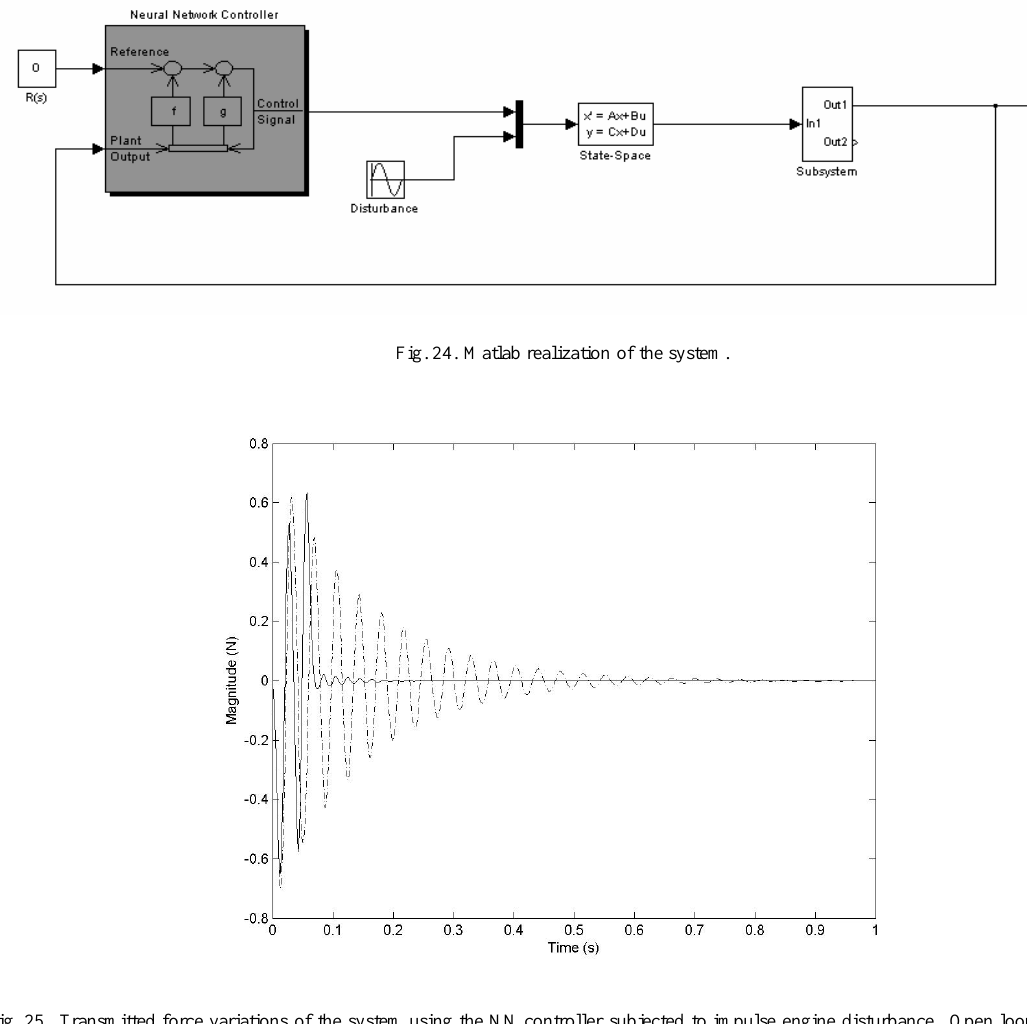
Fig. 25. Transmitted force variations of the system using the NN controller subjected to impulse engine disturbance. Open loop (-.-) and NN controlled